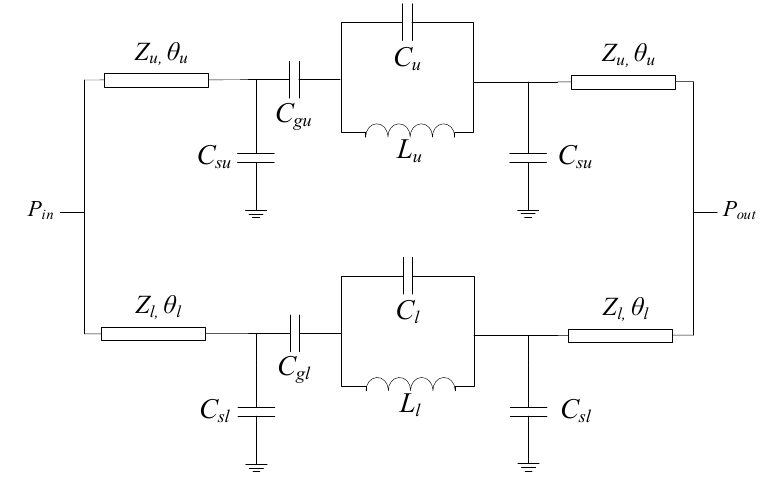
Figure 2. Circuit model of the considered splitter/combiner structure.